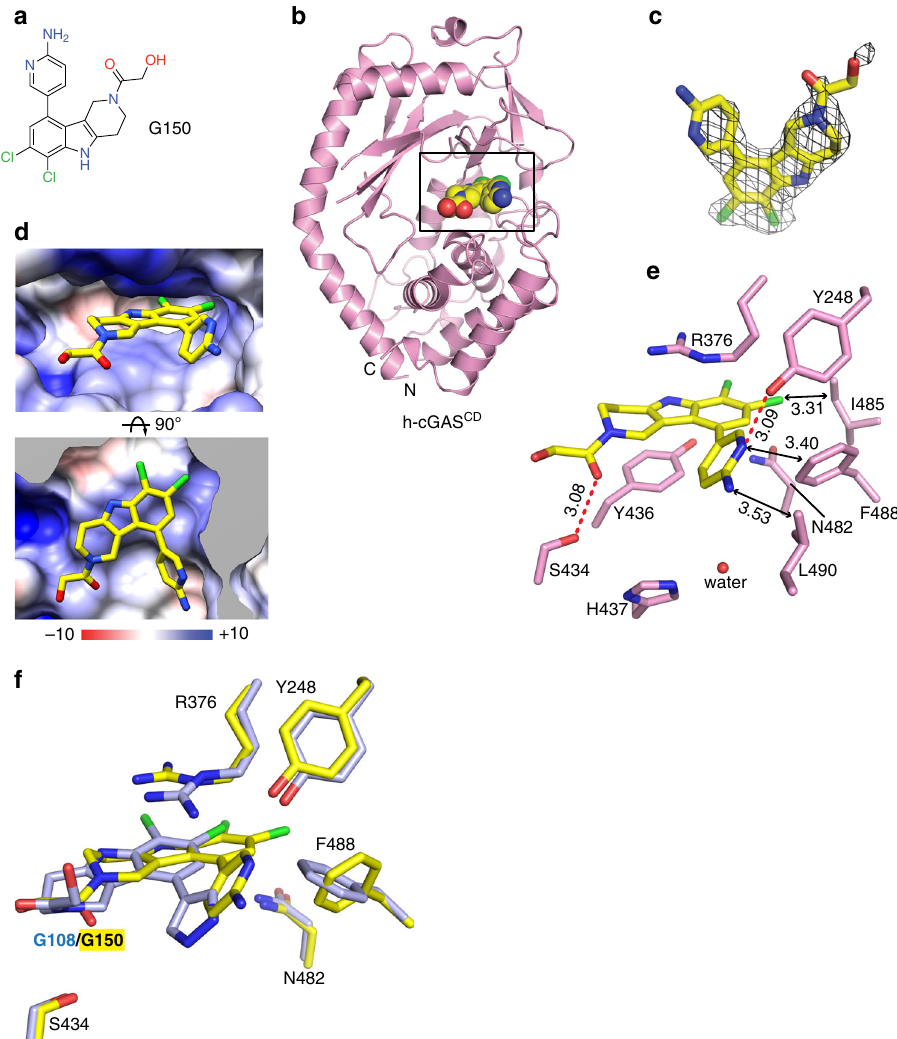
Fig. 5 Structure of G150 bound to apo h-cGAS CD . a Chemical formula of G150 . b Crystal structure of G150 bound to apo h-cGAS CD . The bound G150 is shown in a space- fi lling representation, and the binding pocket is boxed. c 2Fo – Fc electron density map of bound G150 contoured at 1.2 σ level. The electron density is partly de fi ned for the hydroxyl-ethanone side chain attached to the non-planar six-membered ring. d Two views of G150 positioned in its binding pocket within h-cGAS CD with the protein shown in an electrostatic surface representation. Electrostatic surface potentials were calculated with Coulombic Surface tool in Chimera with thresholds ±10 kcal mol − 1 e − 1 . e Intermolecular contacts and key distances between G150 and amino acids lining the binding pocket of h-cGAS CD . Distances are in angstrom. Red dashed lines indicate hydrogen bond. f Superposition of the structures of G108 (light blue) and G150 (yellow) as observed in their complexes with h-cGAS CD . Note that G150 is positioned deeper in the binding pocket than G108 so that the pair of chlorine atoms do not superposition with each